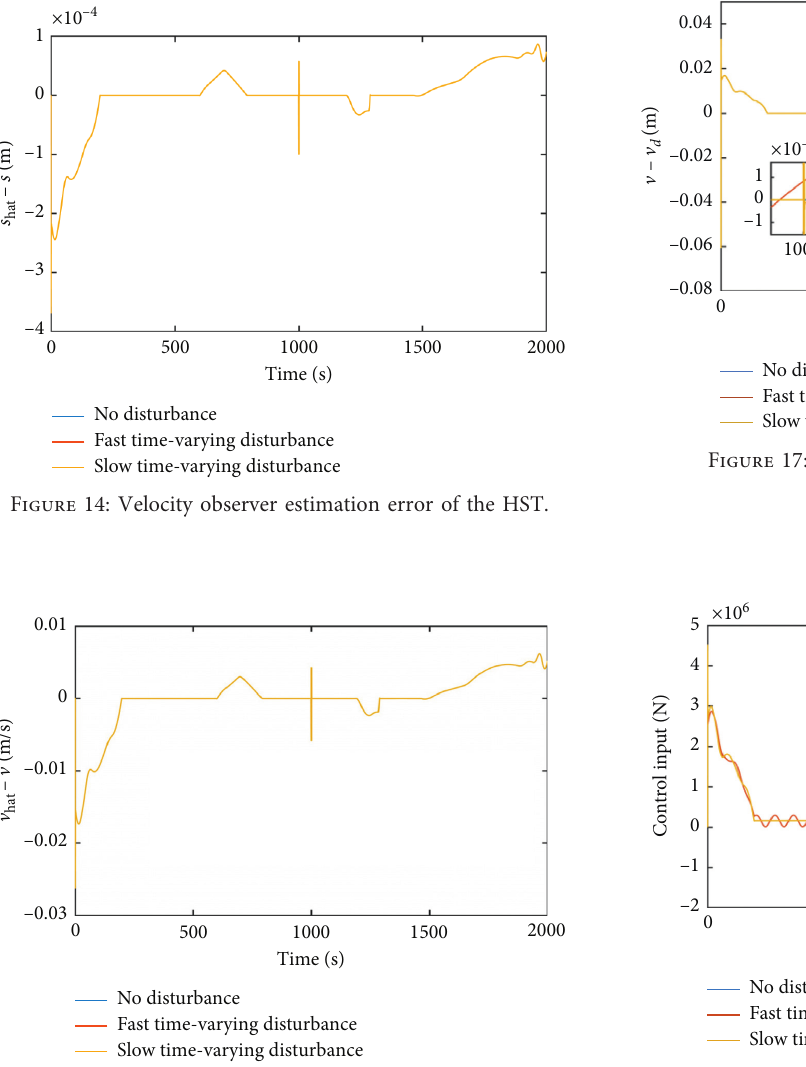
Figure 15: Velocity observer estimation error of the HST.